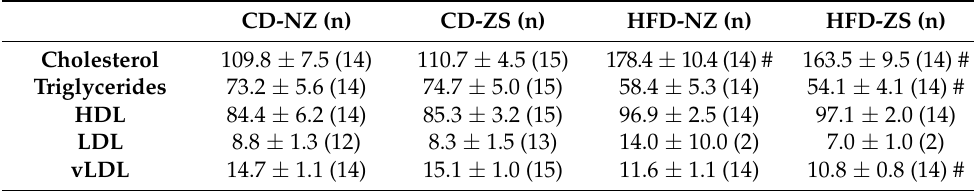
Table 1. Plasma levels of total cholesterol, triglycerides, HDLs, LDLs,